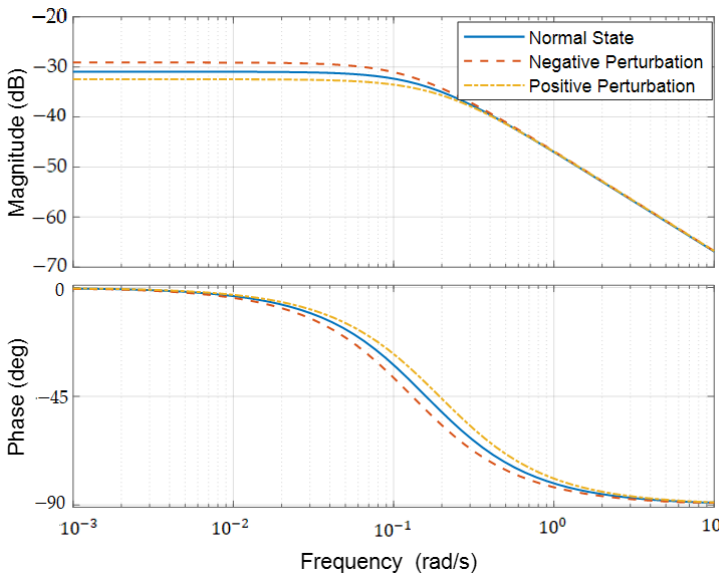
Figure 10. Yaw Channel Bode Plot of Axial Mass Center Perturbation.